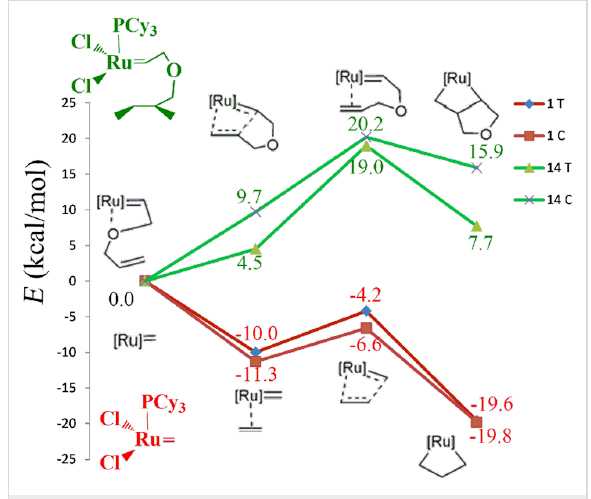
Figure 6: Energy profiles for systems 1 and 14 .